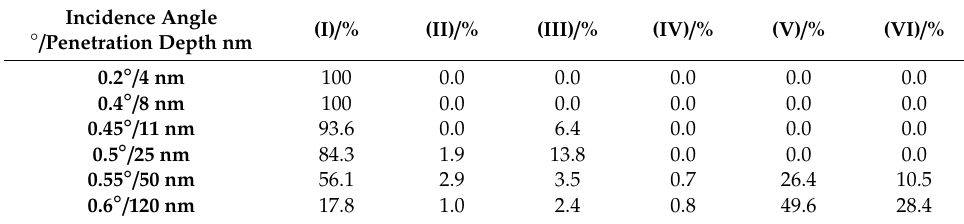
Figure 7. Two kinds of crystalline lattices with di ff erent orientations. ( I ), ( III ), and ( V ) are Type 1, while ( II ), ( IV ), and ( VI ) are Type 2. Reproduced with permission [29]. 2018, American Chemical Society. Table 1. Population of each microcrystalline structure at a given α i